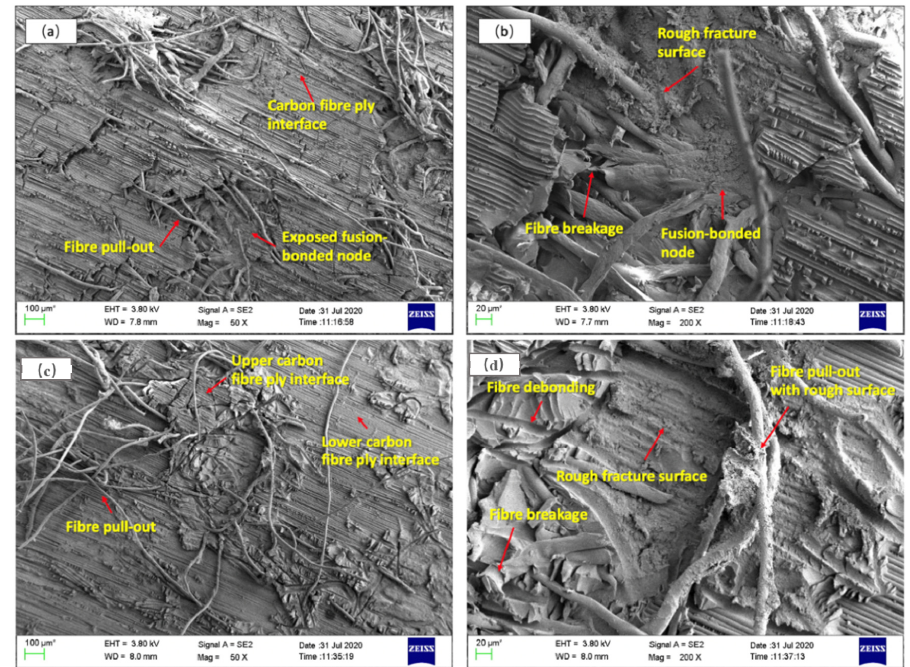
Figure 14. SEM images of Mode II fracture surface. ( a , b ) Lower surface, ( c , d ) upper surface.